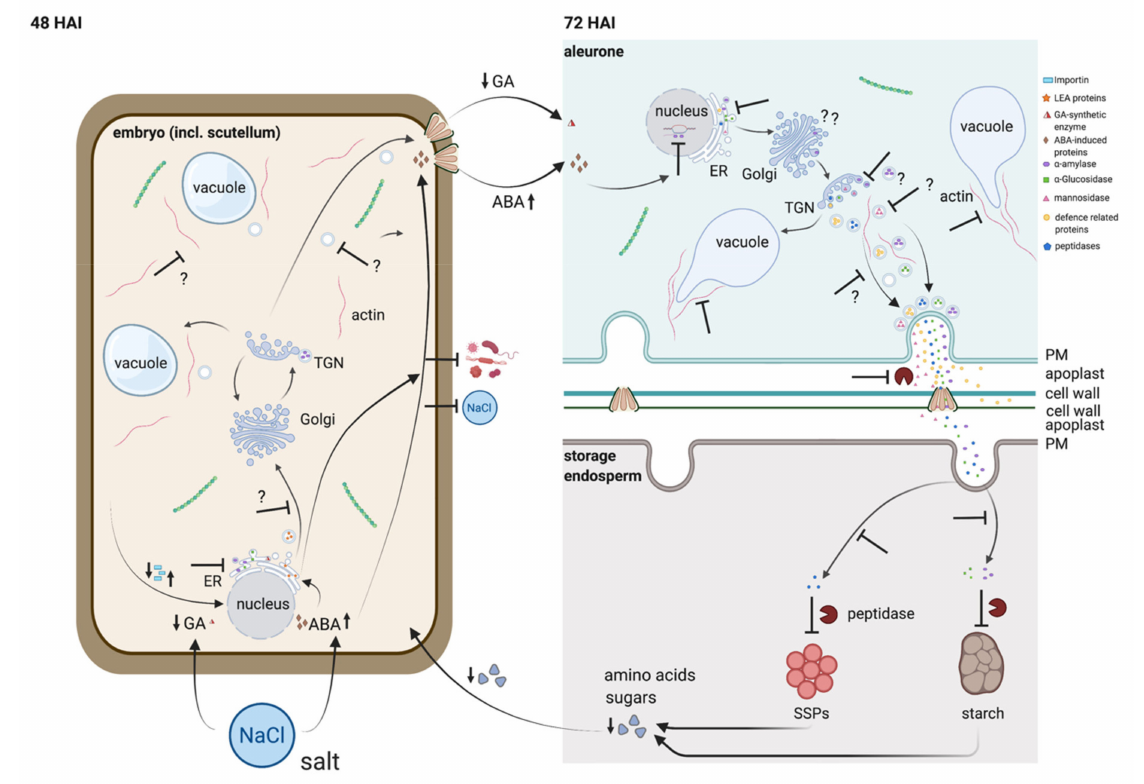
Figure 8. Model for the effect of salt on the cytoskeleton, protein trafficking, and protein mobilization during barley germination. The expression of proteins was most different between H 2 O and EC30 at 48 HAI and 72 HAI in the embryo and endosperm, respectively. We hypothesize that on the one hand, ABA is induced in the embryo by EC30, which inhibits the expression of α -amylase, α -glucosidase, peptidases, mannosidase, and defence-related proteins. On the other hand, the expression of GA 3 -responsive proteins seemed to be negatively affected by the salt treatment. Subsequently, starch and SSPs are less hydrolysed and digested, leading to less mobilization of amino acids and sugars to the embryo. The actin cytoskeleton is altered in the aleurone, and vacuolization is inhibited by salt stress, putatively affecting the vesicular trafficking in the secretory pathway. Arrow up/down: high/low substance level, T-line: inhibition/reduction. Created with